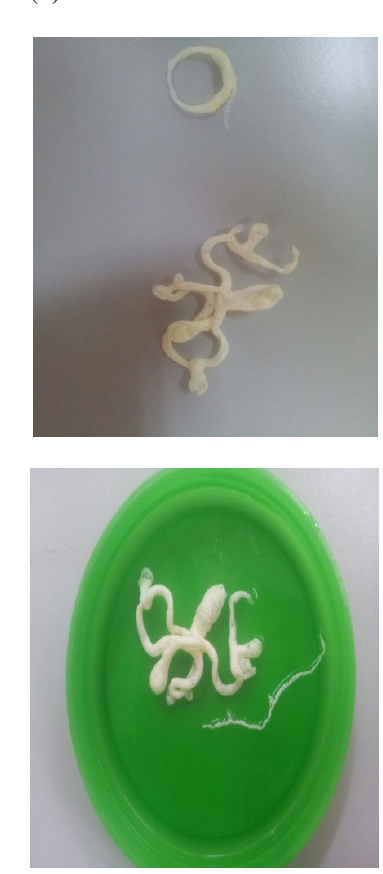
Fig. 3. Synthesis of rayon (regenerated cellulose).